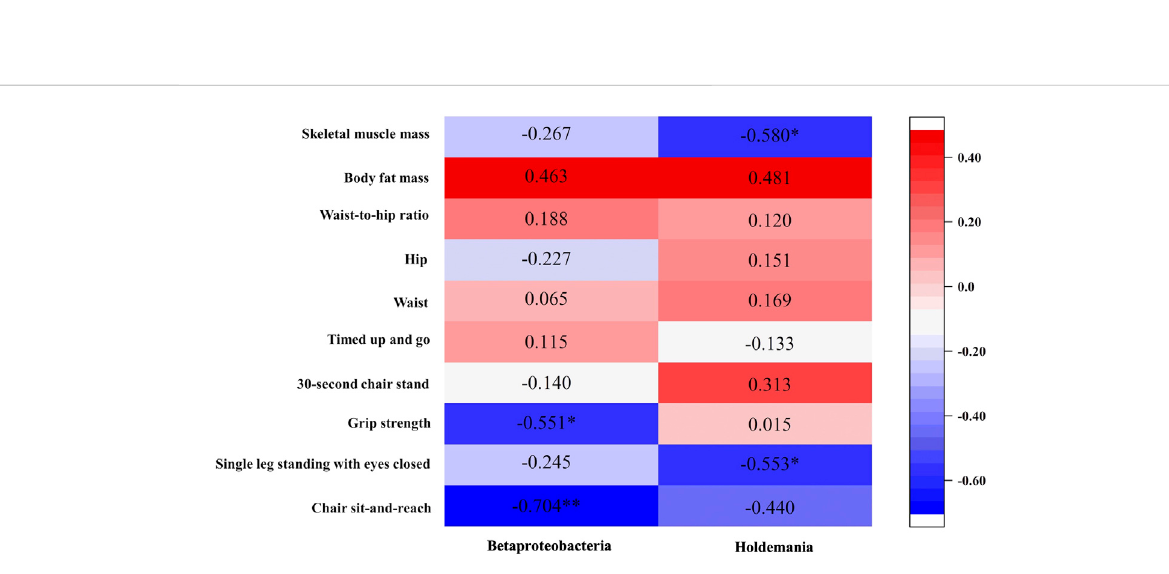
FIGURE 5 Relationship between changes in physical function and changes in gut microbiota after exercise